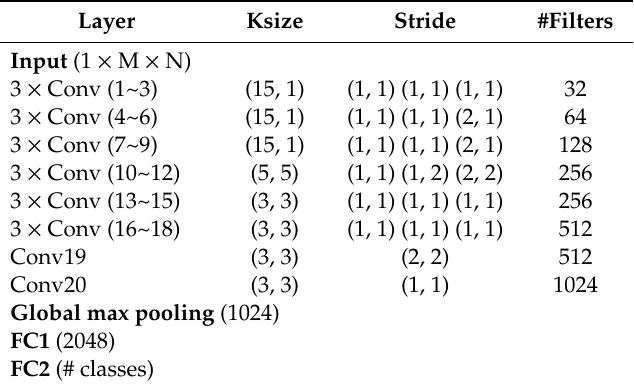
Table 2. Architecture of the 2D network and full